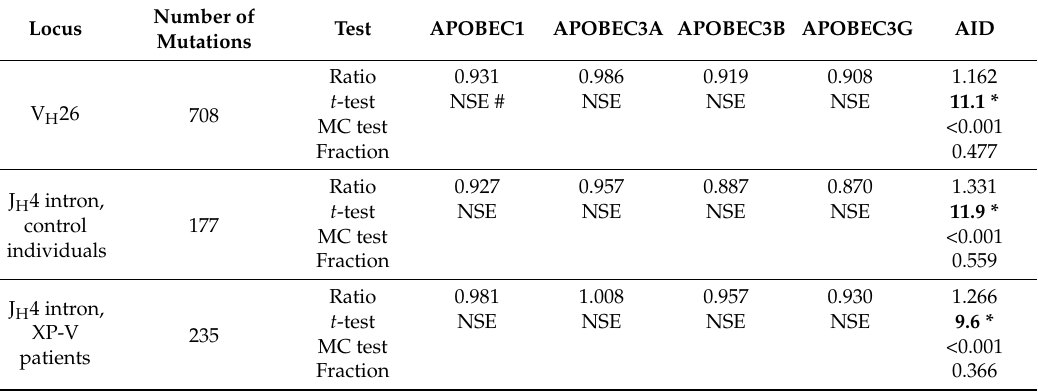
Table 3. Correlation between the AID/APOBEC mutable motifs and the sequence context of somatic mutations in fragments of human immunoglobulin